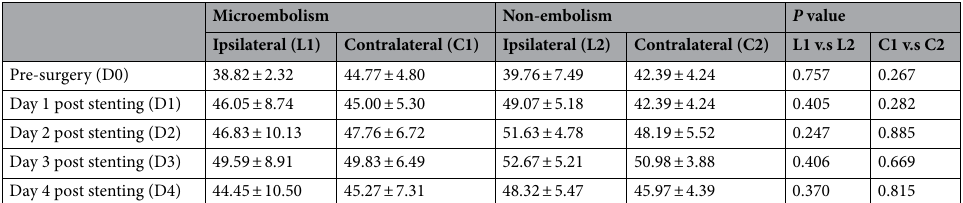
Table 4. The cerebral blood flows (mL/100 g/min) in frontoparietal lobes of patients with or without